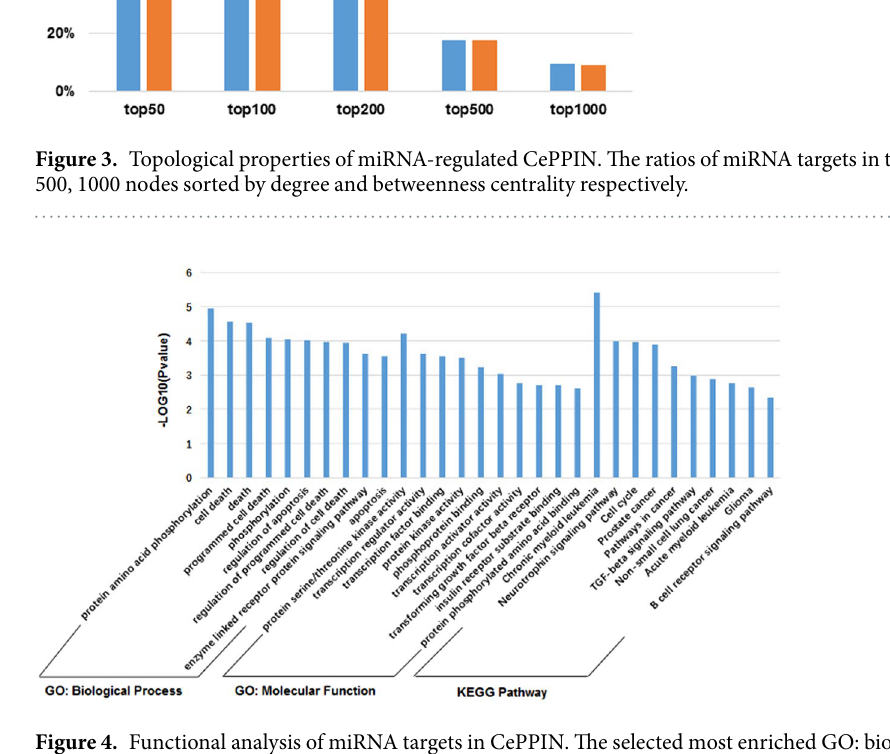
Figure 4. Functional analysis of miRNA targets in CePPIN. The selected most enriched GO: biological process, GO: molecular function and KEGG pathway terms (p-value < 0.05) for all miRNA